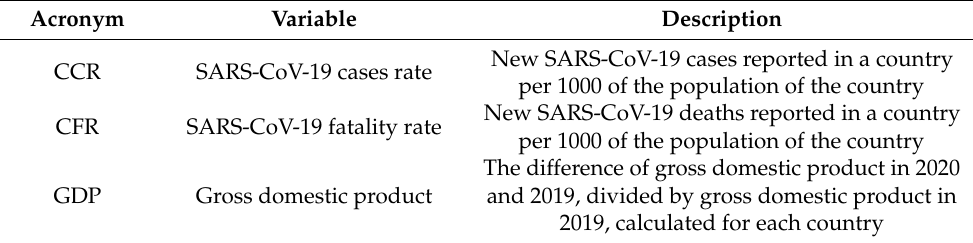
Table 2. Variables used in the